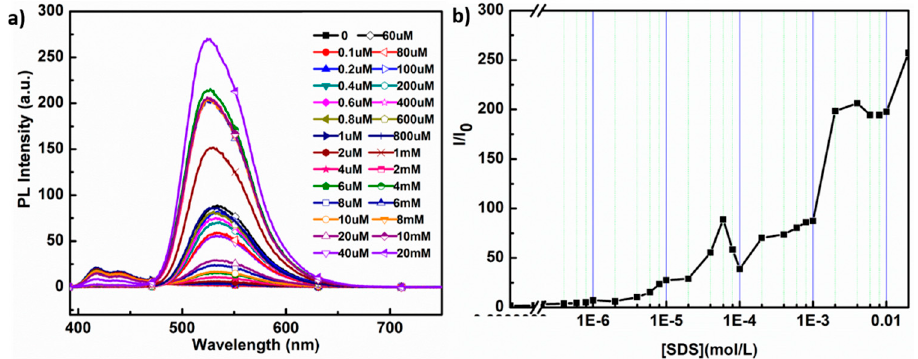
Figure 3. ( a ) PL spectra of PFC3NBT in the absence and presence of SDS with the concentrations of SDS ranging from 0 to 20 M m ; ( b ) fluorescence intensity at 545 nm ( I 545 ) in the prescence of SDS at adverse concentrations vs. that in the absence of SDS ((RU) of PFC3NBT = 4.5 μ M, excitation at 380 nm).